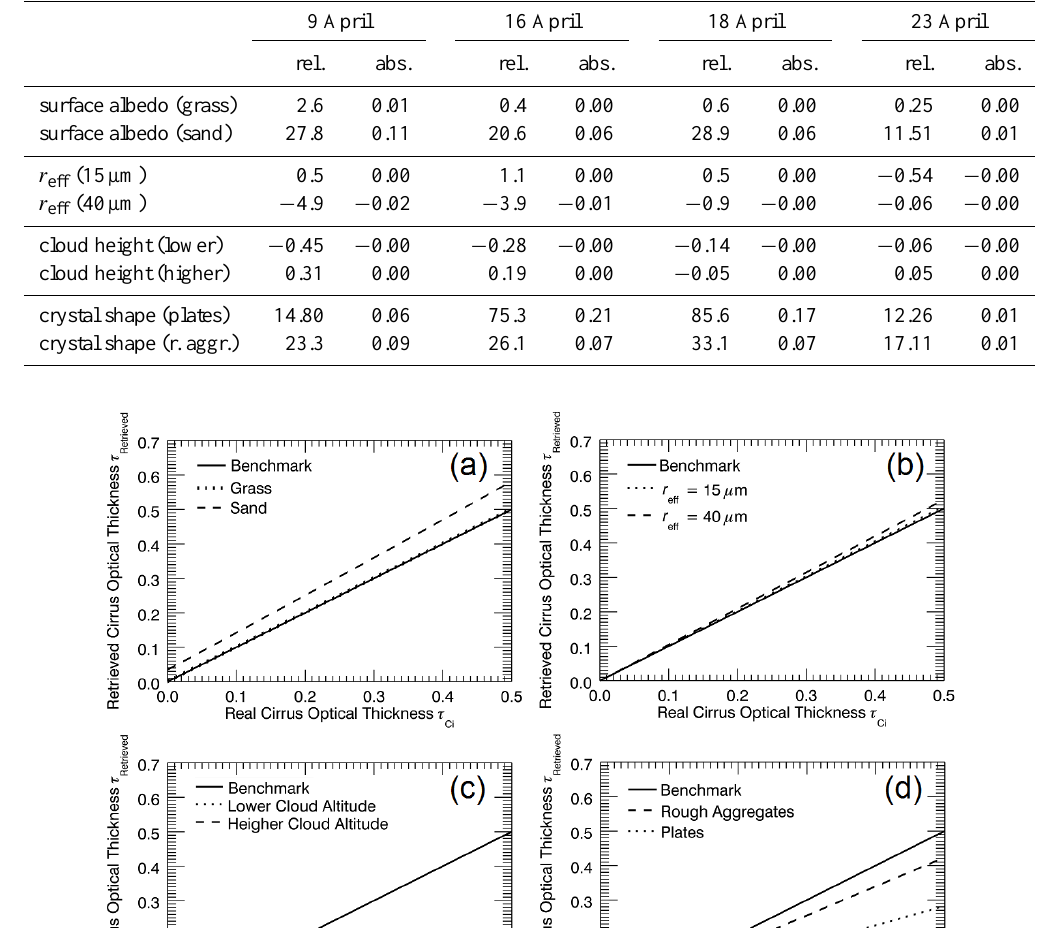
Table 2. Relative (%) and absolute difference of retrieved τ ci in comparison to benchmark case.